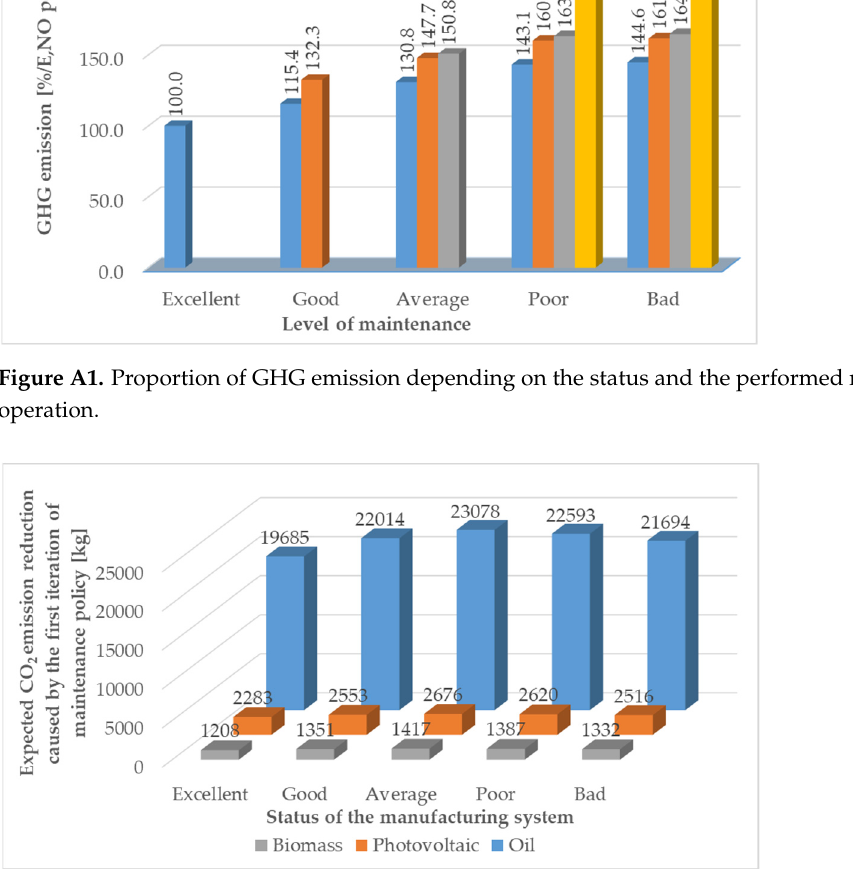
Table A3. Impact of the discounting parameter on the discounted profit resulting from the optimized maintenance policy in the case of different initial status of the system (best status is Status 1 and worst status is Status